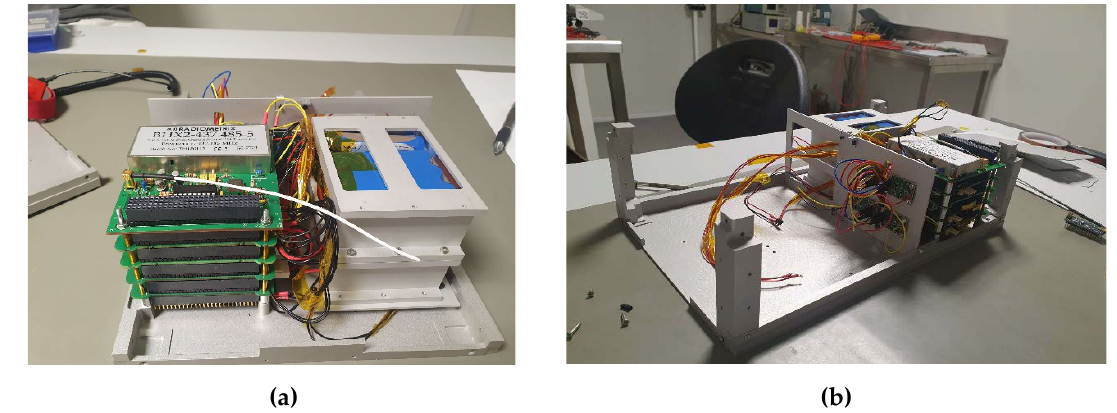
Figure 4. ( a ) View of the Service Module, ( b ) view of the entire platform with focus on the Propulsion box.